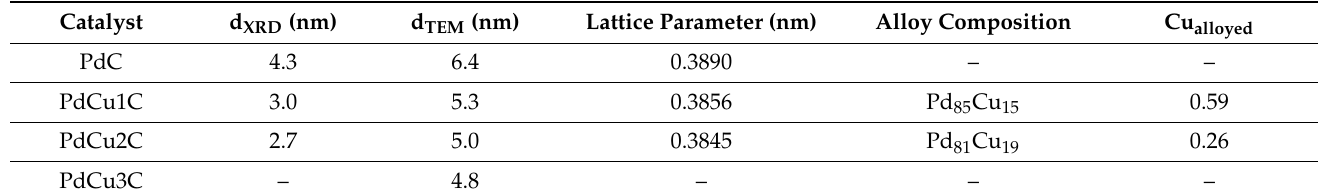
Table 2. Nominal and actual metal wt.% loading and Pd:Cu atomic ratio for the different electrocatalysts. Alloy